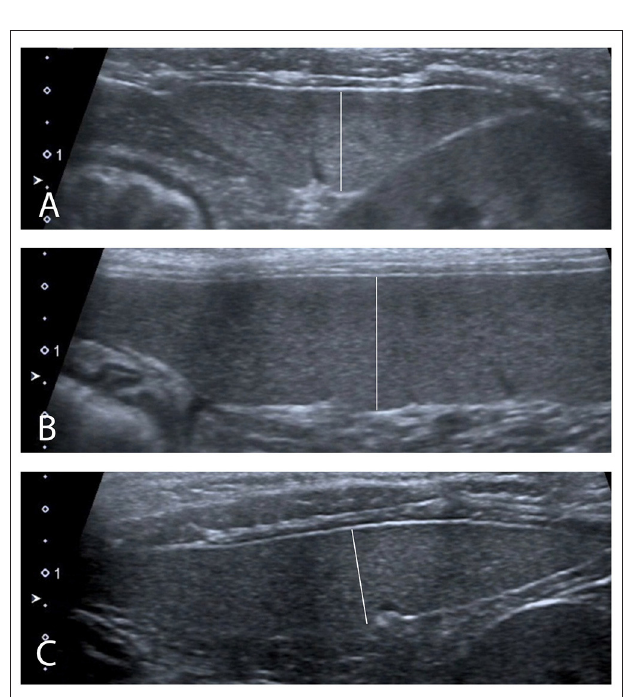
FIGURE 2 | Ultrasound measurements performed (A) In transverse plane at the level of the head of the spleen. (B) In sagittal plane at the level of the body of the spleen. (C) In transverse plane at the level of the tail of the